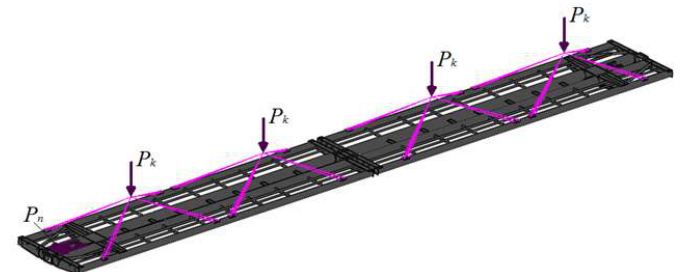
Figure 10. Design diagram of the carrying structure of the flat wagon.